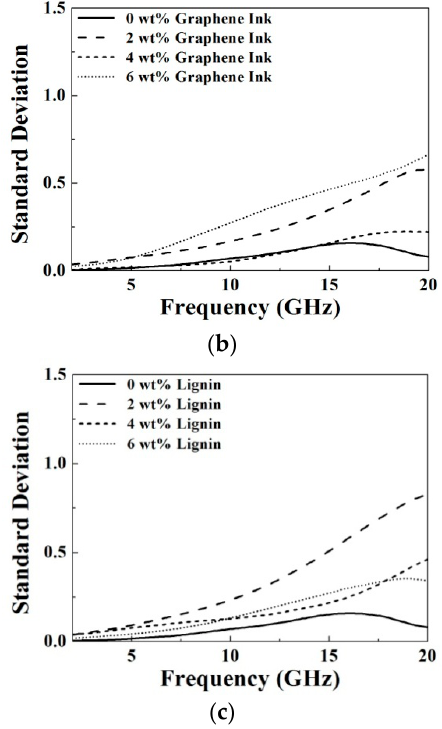
Figure 6. The calculated standard deviation of the measured conductivity for the prepared samples with different doping materials, including ( a ) carbon nanotube; ( b ) graphene ink and ( c ) lignin.